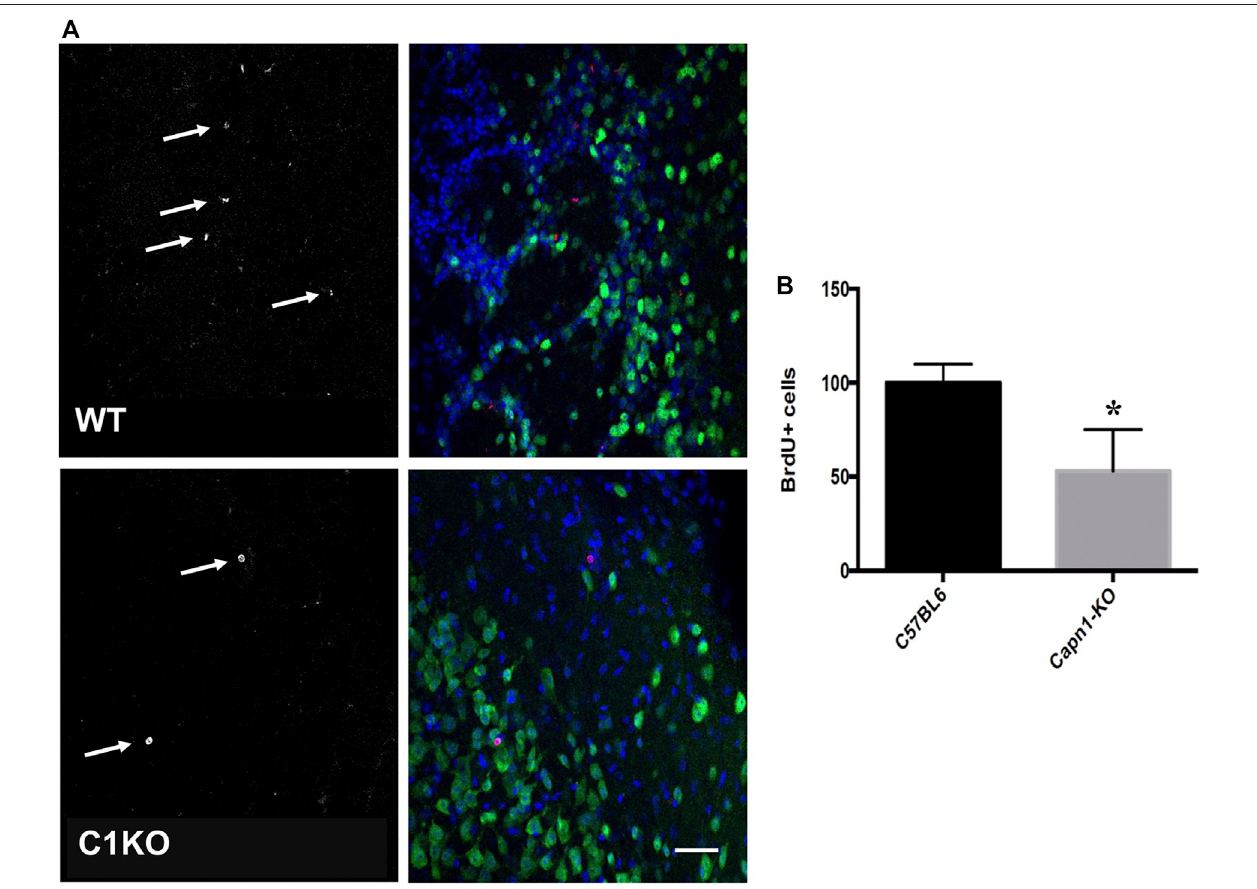
FIGURE3| BrdU+cells intheolfactory bulbs ofWT and C1KOmice. WTand C1KO micewereinjected with5-bromo-2-deoxyuridine(BrdU)(50 mg/kg) every8 h for 3 days,atotalofnine injections. Brains werecollected following transcardial perfusion 30 days after the fi rst BrdUinjection. Brainswere sectioned and sections were processed for immunolabeling with antibodies against BrdU (A) , left panels arrows, red in left panels) and NeuN (A) , right panels, green). Sections were counterstained withDAPI(blue).NumbersofBrdU+cellswerequanti fi edasindicatedinthe MaterialsandMethods section (B) .Fivesections permousewerequanti fi edand5WT and C1KO mice were analyzed. Results are expressed as percent of the average number of cells in the WT mice and are Means ± SEM of 5 mice per group. * p < 0.01, Student ’ s t-test. Scale bar: 50 µm.